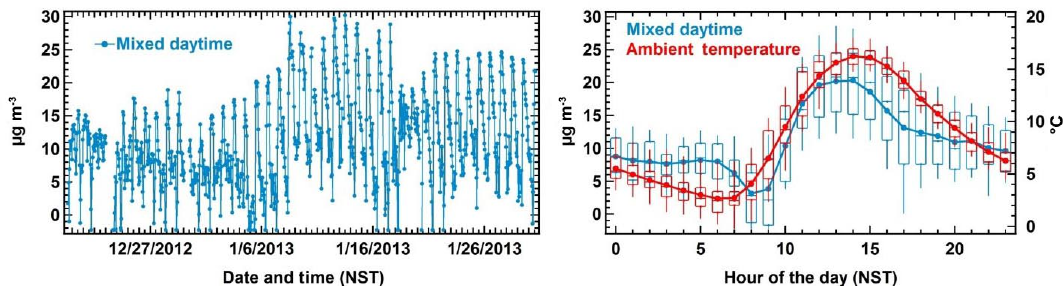
Figure 10. Time series and diel box and whisker plot for Factor 7 (mixed daytime).